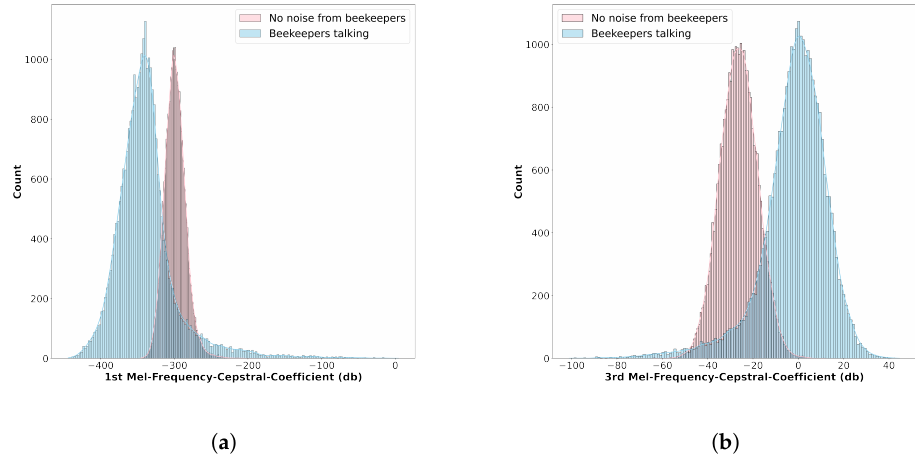
Figure 11. Comparison of the changes in distribution of the ( a ) first and ( b ) third mel frequency cepstral coefficient with and without the presence of human speech.